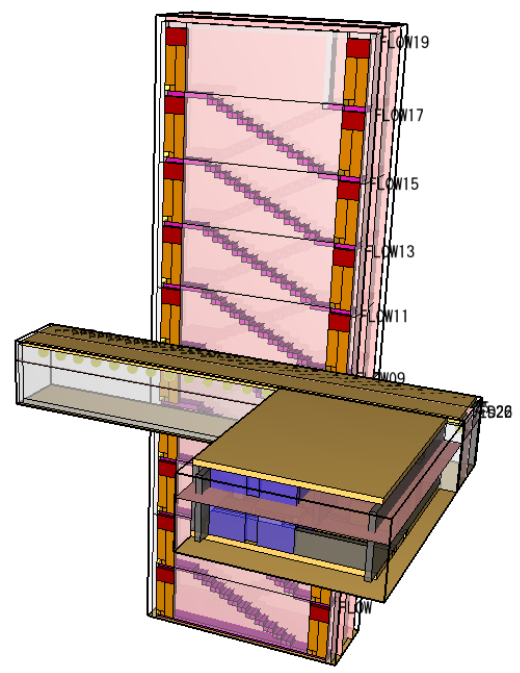
Figure 2. Model: ( a ) Side view, ( b ) Front view, ( c ) Top view.